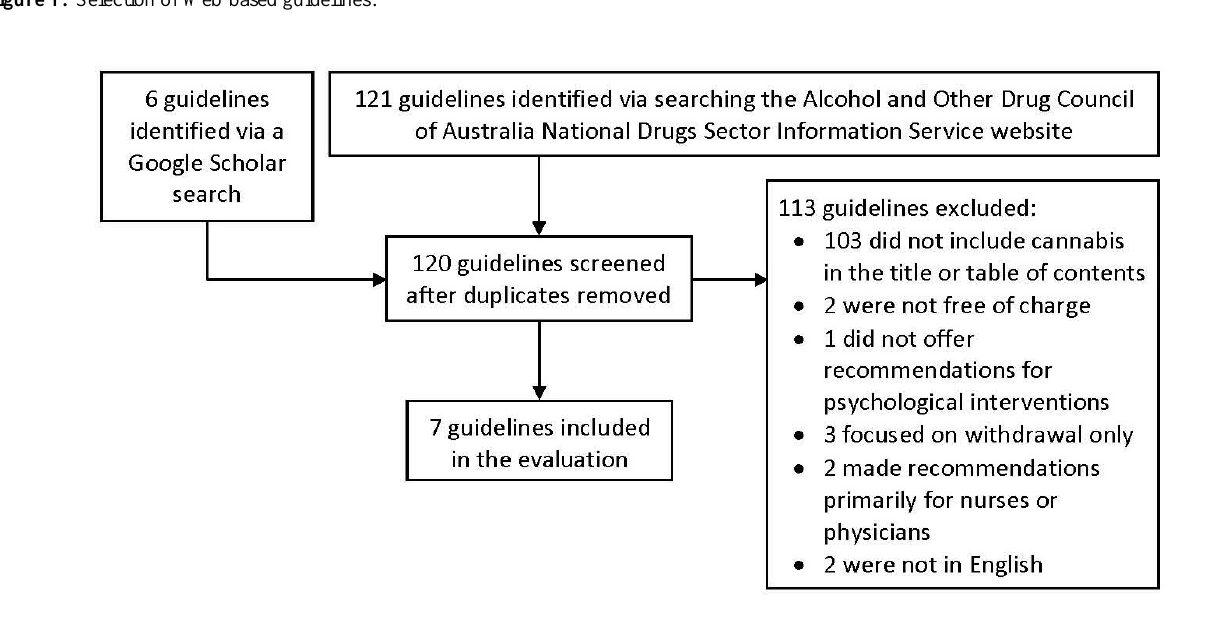
Figure 1. Selection of Web-based